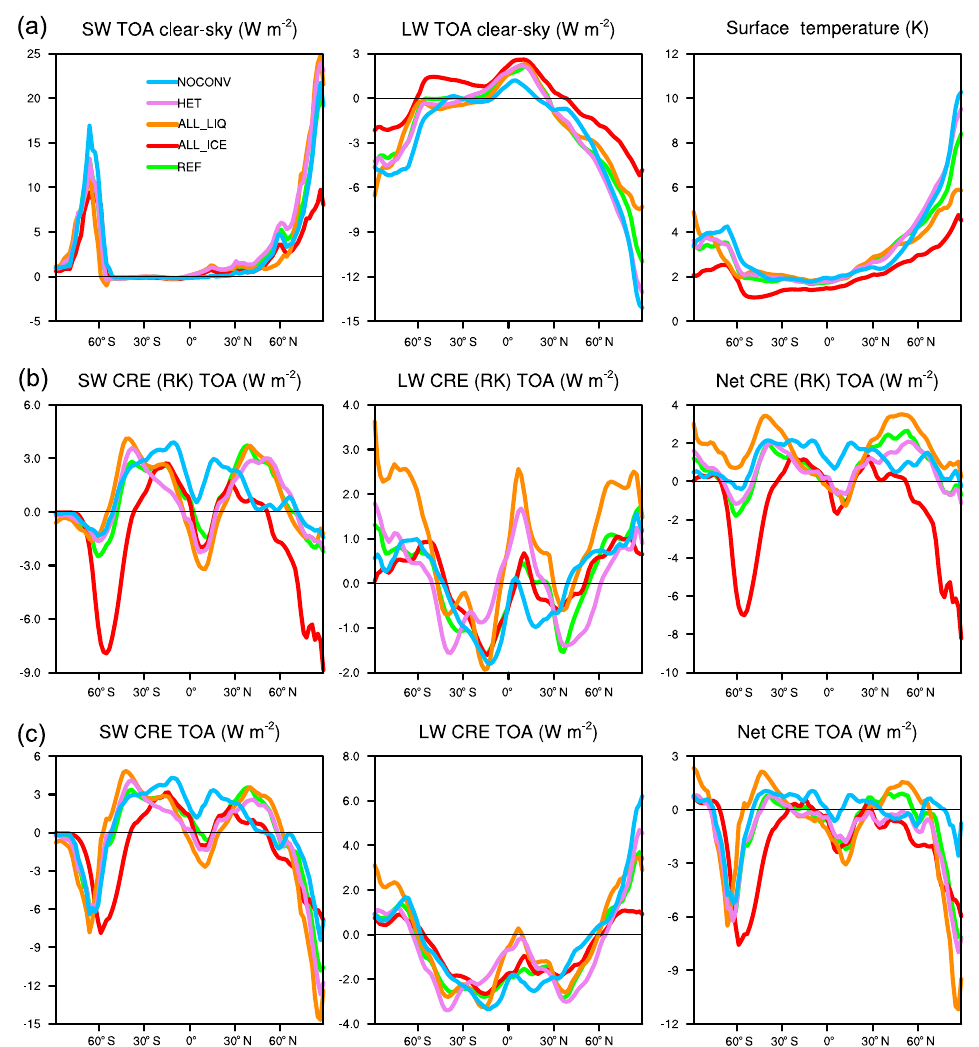
Figure 10. Changes in the annual zonal SW and LW net clear-sky radiation in watts per square meter at the top-of-the-atmosphere and surface temperature (K) (a) ; changes in SW, LW, and net cloud radiative effects between the 2 × CO 2 and 1 × CO 2 climates calculated based on the radiative kernel method (b) and normally diagnosed (c) for the simulations described in Table 1. Negative values for the change in clear-sky outgoing longwave radiation denote higher values in the 2 × CO 2 climate. Please note the different vertical